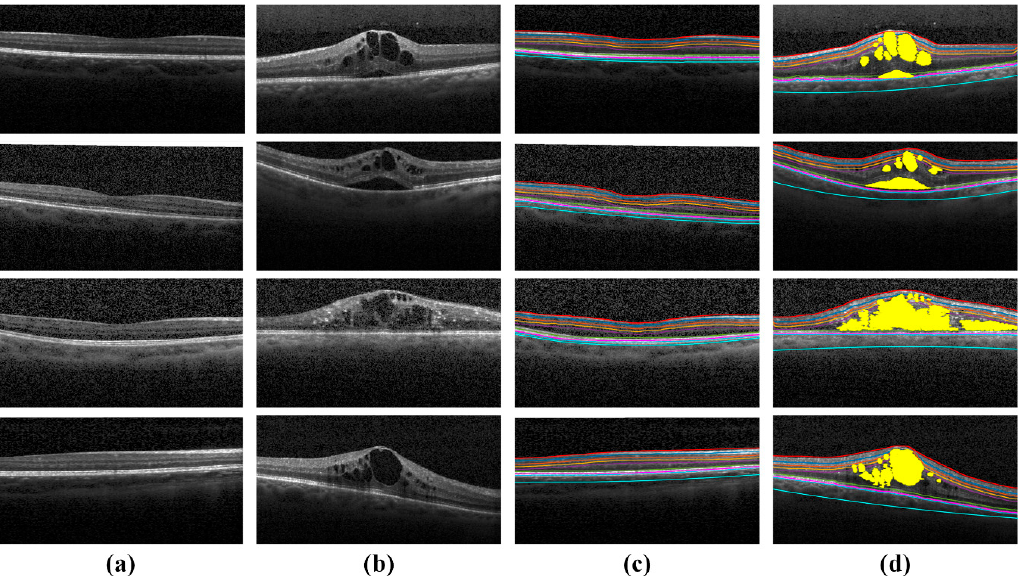
Figure 14. Healthy and ME OCT scans in the Zhang dataset [35], which are processed by the proposed system. ( a ) Original healthy OCT B-scans; ( b ) original ME OCT B-scans; ( c ) classified as healthy by the proposed system and ( d ) classified as ME by the proposed system.